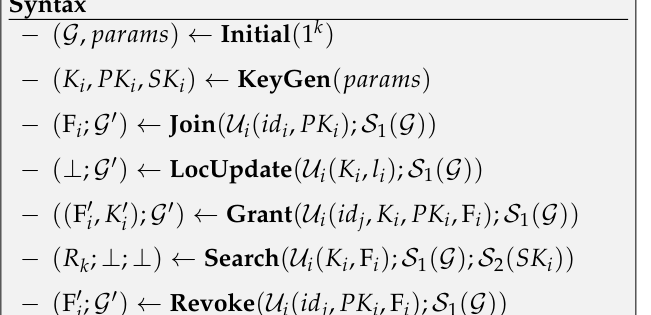
Figure 1. The architecture.